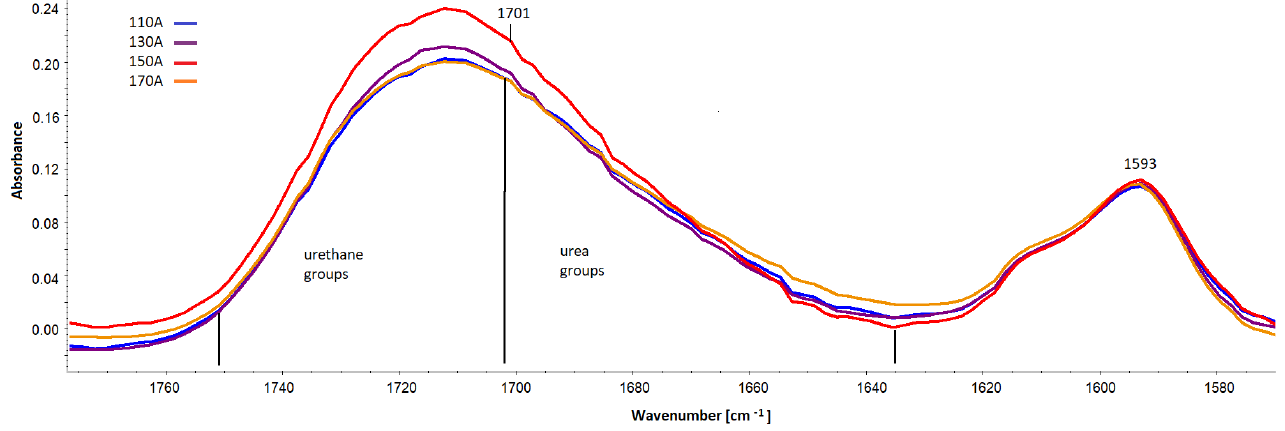
Figure 15. Spectral fragment with a band of carbonyl groups in the range 1635–1750 cm − 1 and a band serving to scale from the C-C bonds in the aromatic group (1593 cm − 1 ). The band from PIR groups at 1412 cm − 1 (Figure 16) was also quantitatively analyzed based on spectra scaled against the 1593 cm − 1 band.